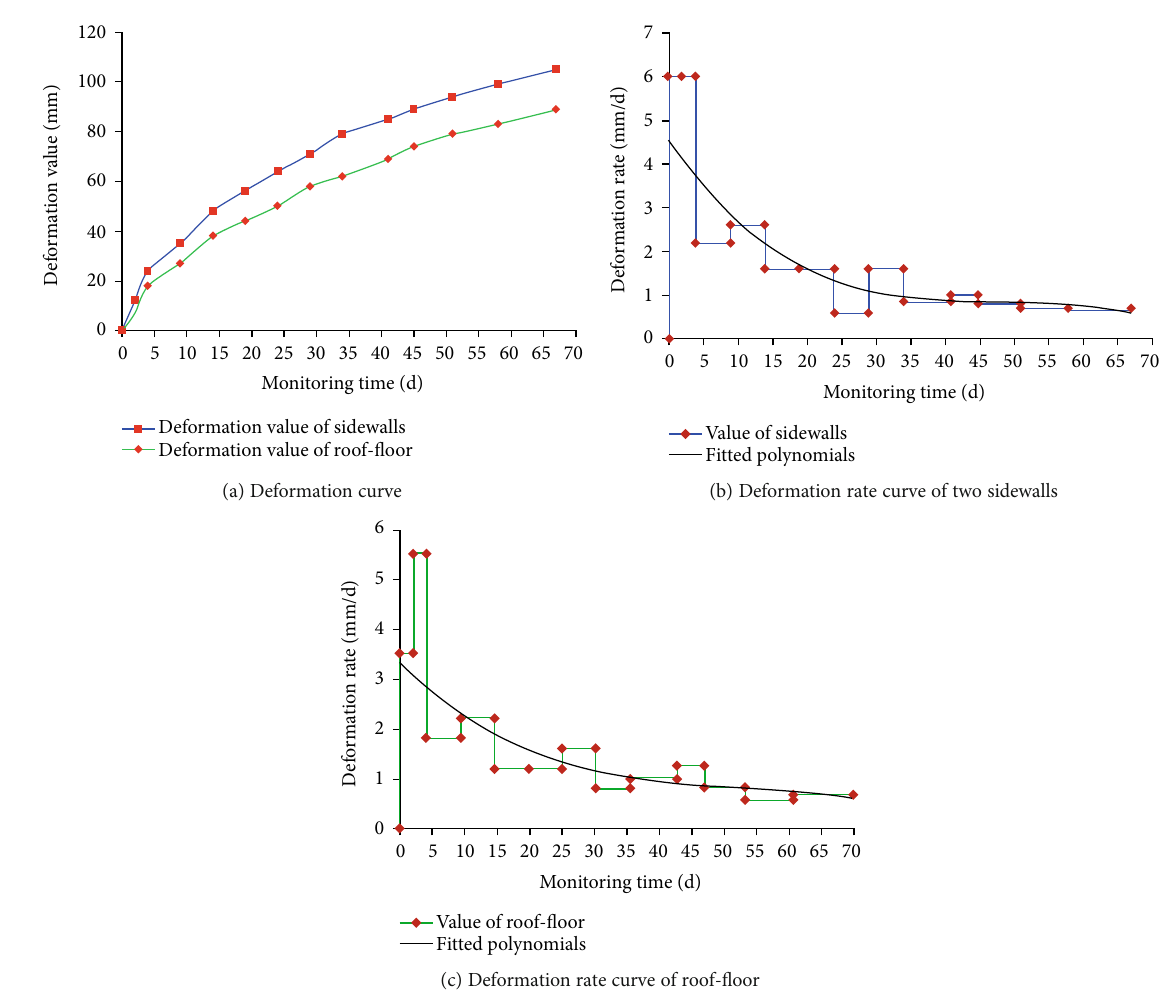
(c) Deformation rate curve of roof- fl oor Figure 13: Deformation monitoring curve after repair of